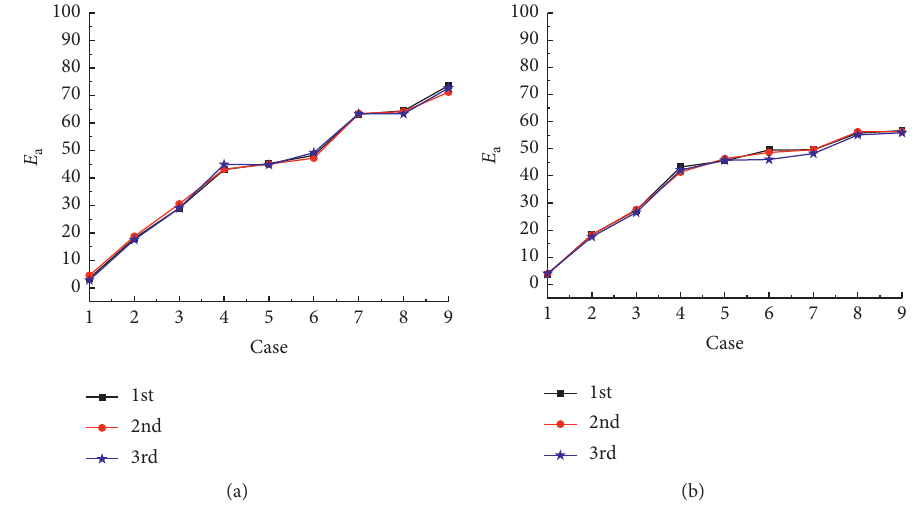
Figure 12: E a for various cases: (a) driving point A; (b) driving point